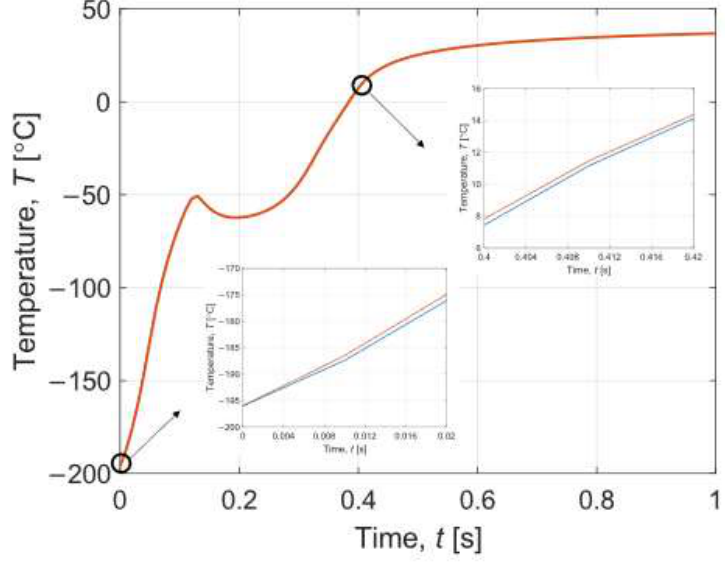
Figure 7. History of interval temperature during warming in time 0–1 s.